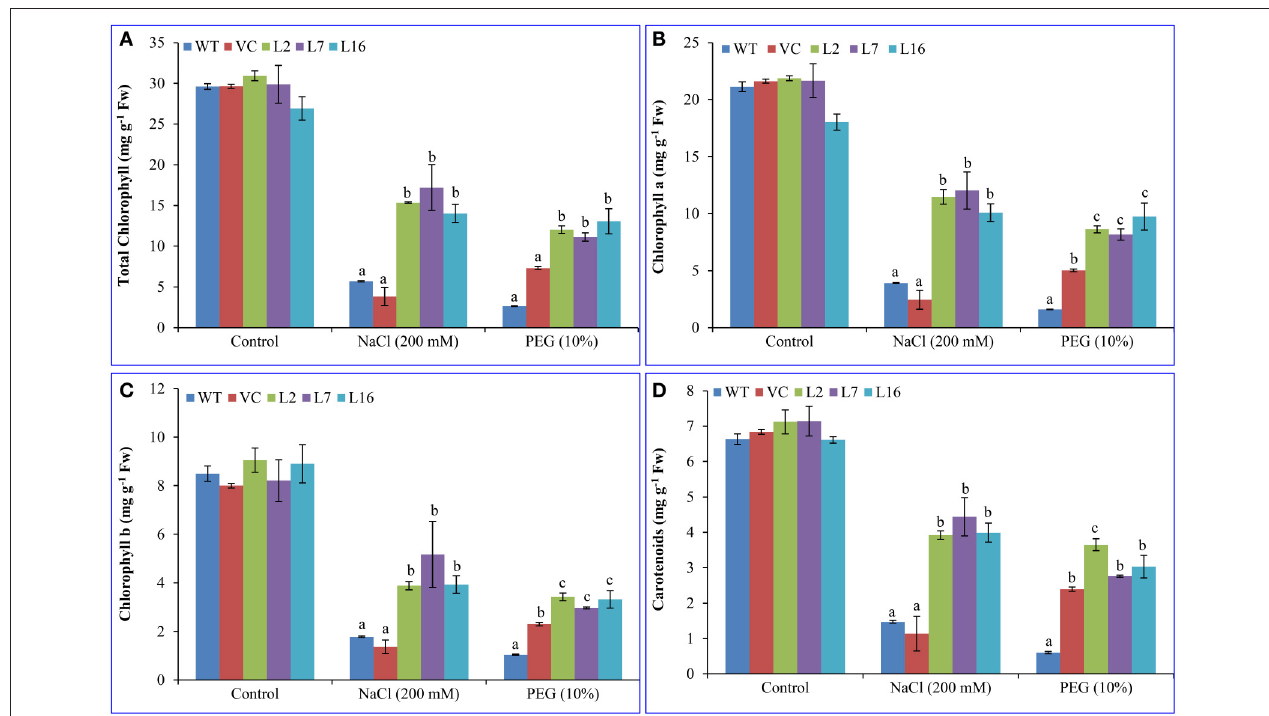
FIGURE 3 | Estimation of chlorophyll content and carotenoids. (A) Total chlorophyll, (B) chlorophyll a, (C) chlorophyll b, and (D) carotenoids contents of transgenic (L2, L7, and L16) and control plants (WT and VC) under salt and osmotic stress condition. Bars represent means ± SE and values with different letters are significant at P <